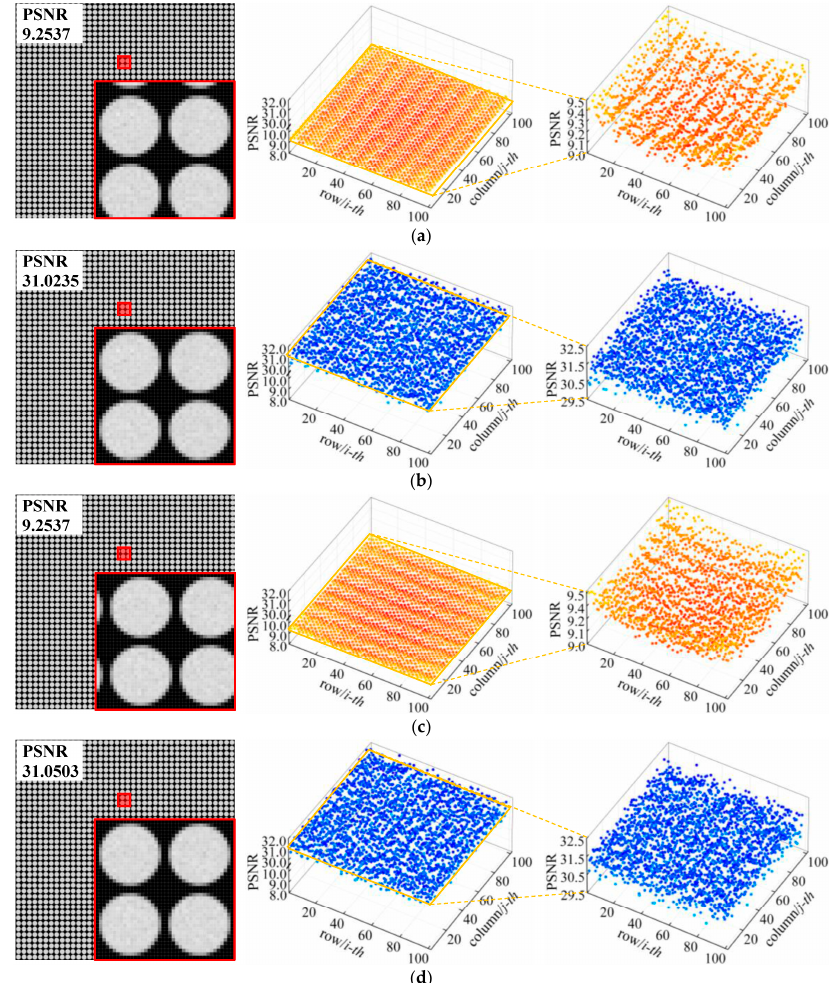
Figure 6. Correction results and deviation distributions for images with translation error: ( a ) Distorted white raw image with an error of Δ t = 15 μ m at φ = 90° and ( b ) its corresponding corrected image; ( c ) Distorted white raw image with an error of Δ t = 15 μ m at φ = 0° and ( d ) its corresponding corrected image. The PSNR values of each case are displayed in the upper left corner of the image.